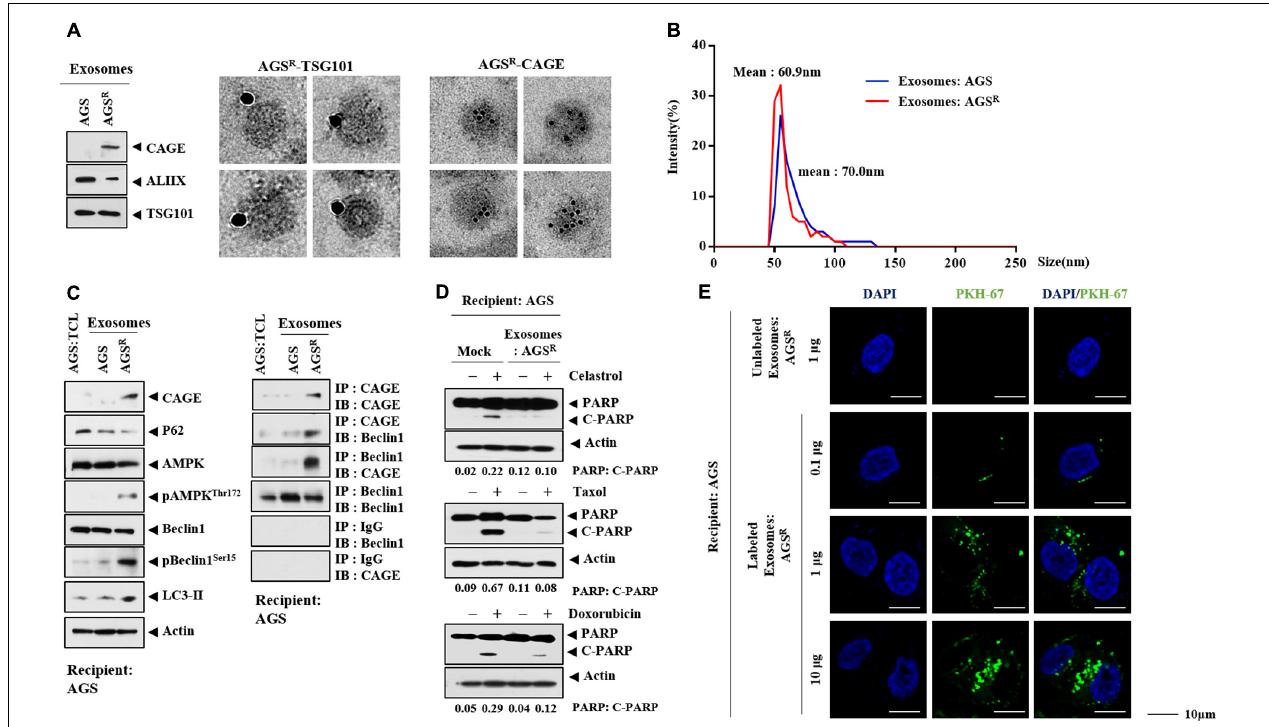
FIGURE 7 | Exosomes of AGS R cells enhance autophagic flux and decrease the PARP cleavage. (A) Immunoblot (left) and ImmunoEM (left) show the presence of CAGE in the exosomes. Immunogold staining images using anti-TSG101 and anti-CAGE antibody are shown. Twenty-five and 10 nm gold particles are used to indicate the localization of TSG 101 and CAGE, respectively. CAGE is present in the lumen of the exosomes. (B) Size distribution of exosomes is shown. (C) Exosomes (10 µ g/ml) of the indicated cancer cells were added to AGS cells for 24 h. TCL denotes total cell lysates. Representative blots of three independent experiments are shown. (D) AGS cells were treated with or without exosomes (10 µ g/ml) of AGS R cells for 24 h, followed by treatment with the indicated anticancer drug for 24 h. Representative blots of three independent experiments are shown. (E) Exosomes (10 µ g/ml) of AGS R cells were labeled with or without PKH67. Exosomes were then added to AGS cells for 24 h.